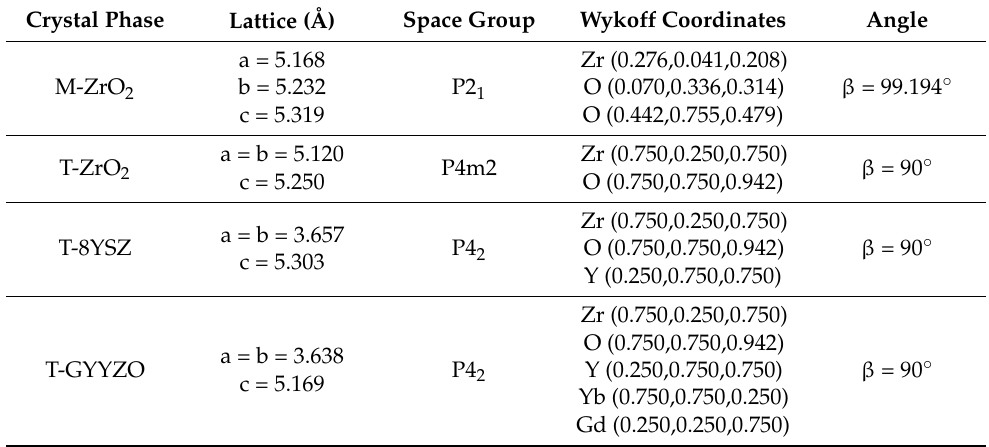
Table 7. Lattice parameters of the unit cells and the space group of the phases in the ceramics. Crystal phase